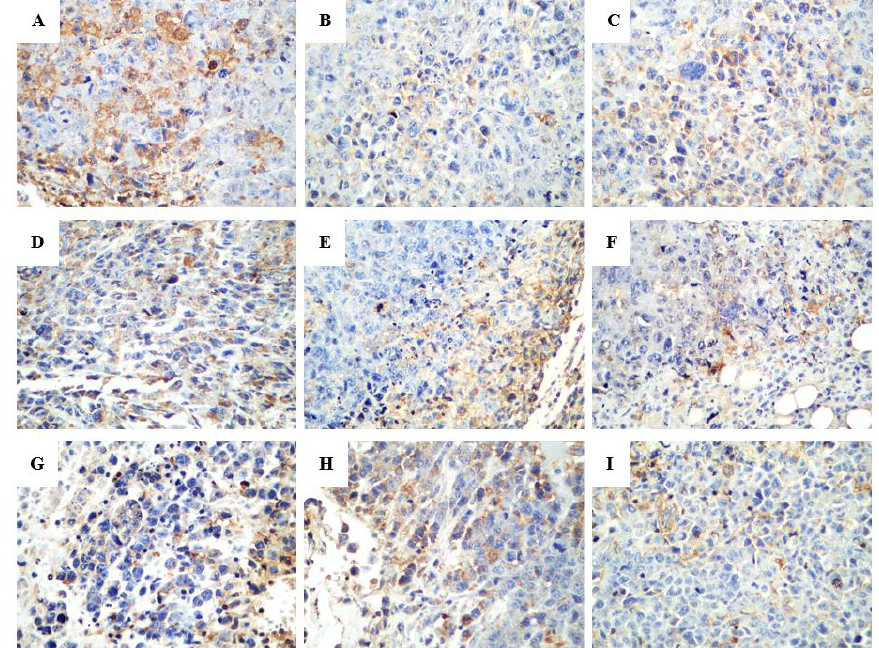
Figure 8. Representative histologic examination of morphological changes in tumors from H22-tumor bearing mice. Protein expression of Bcl-2 in H22-tumor tissues was examined by immunohistochemistry (400×). ( A ) Model control, ( B ) CTX, ( C ) Rh 2 -H, ( D ) R-PHQ-L, ( E ) R-PHQ-M, ( F ) R-PHQ-H, ( G ) S-PHQ-L, ( H ) S-PHQ-M, ( I ) S-PHQ-H.